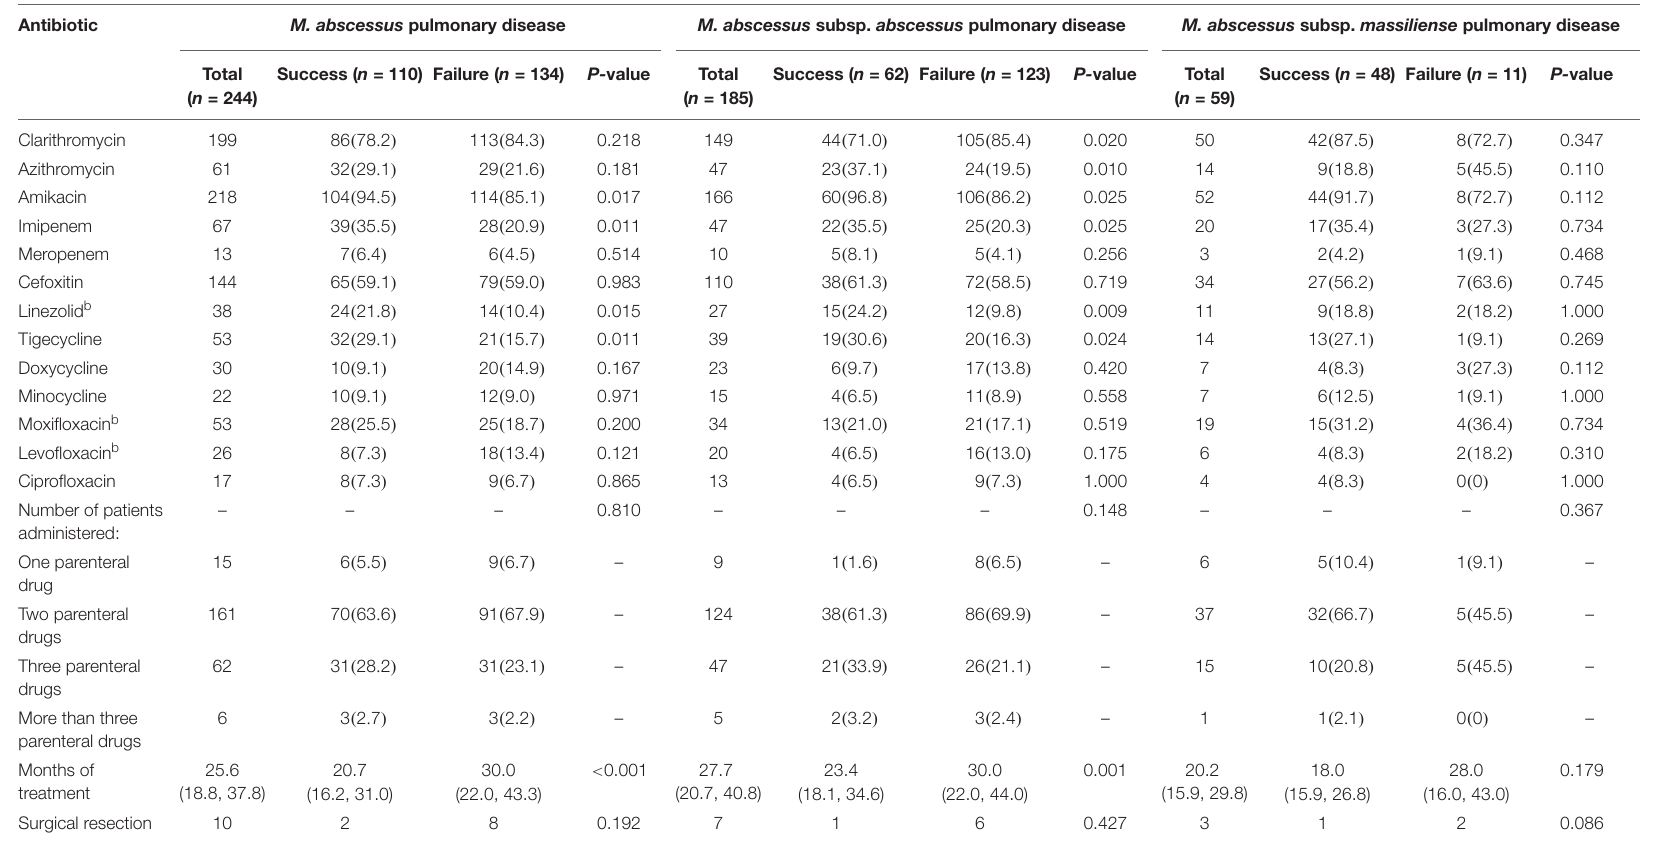
TABLE 2 | Comparison of treatment modalities: success versus failure a